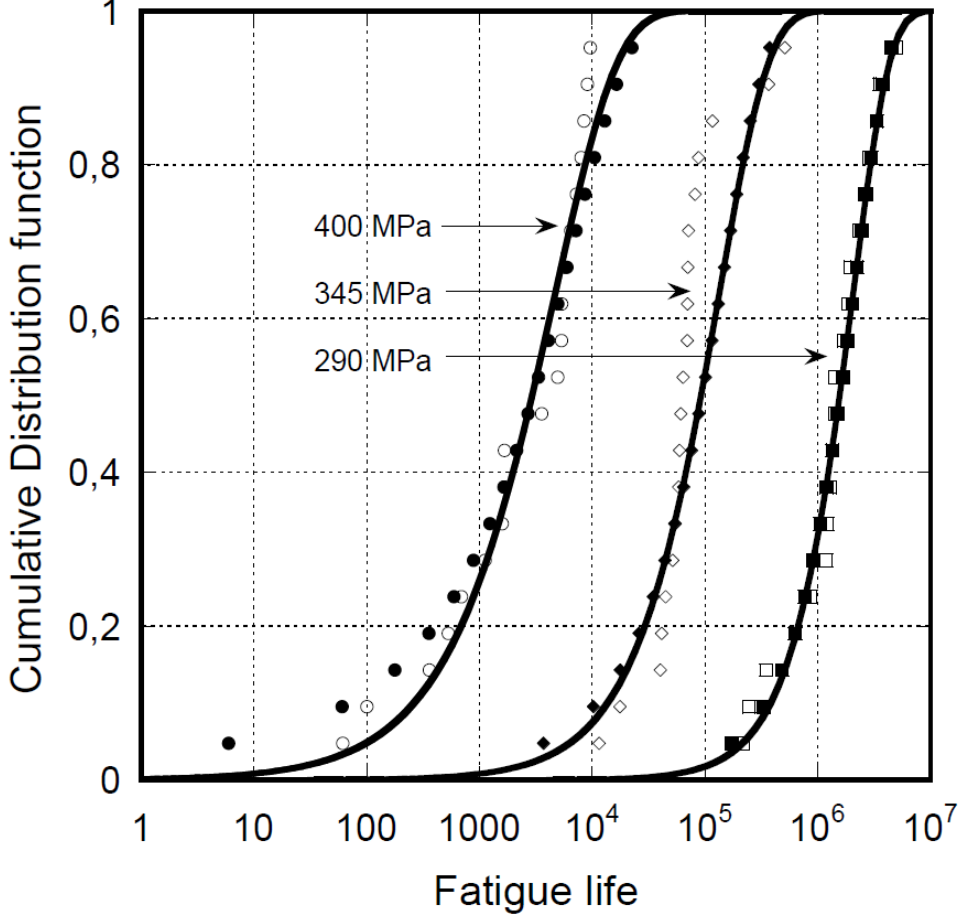
Figure 3. Experimental and calculated fatigue life data for T300/934 graphite/epoxy laminates with a (0/45/90-452/90/45/0) 2 lay-up, at different maximum stresses, σ max , namely 400, 345, and 290 MPa (circle, diamond, and square symbols, respectively), and R = 0. Empty symbols represent the experimental data. The filled symbols are the predictions from Caprino’s model and the continuous curves are the Weibull representation of the predicted data. The experimental data are re-elaborated from the literature [6]. Table 1. The Weibull parameters for fatigue life.